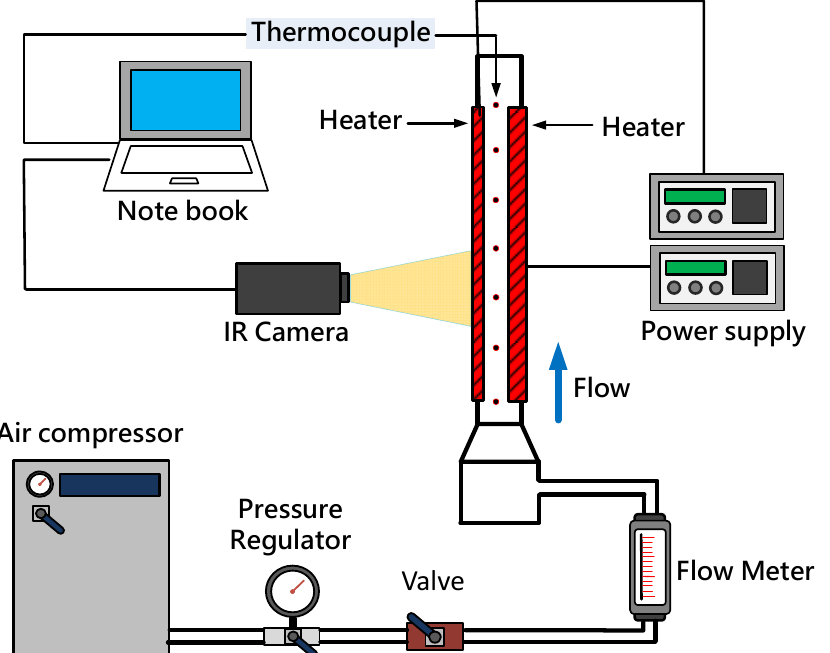
Figure 1. Experimental setup for heat transfer measurement.